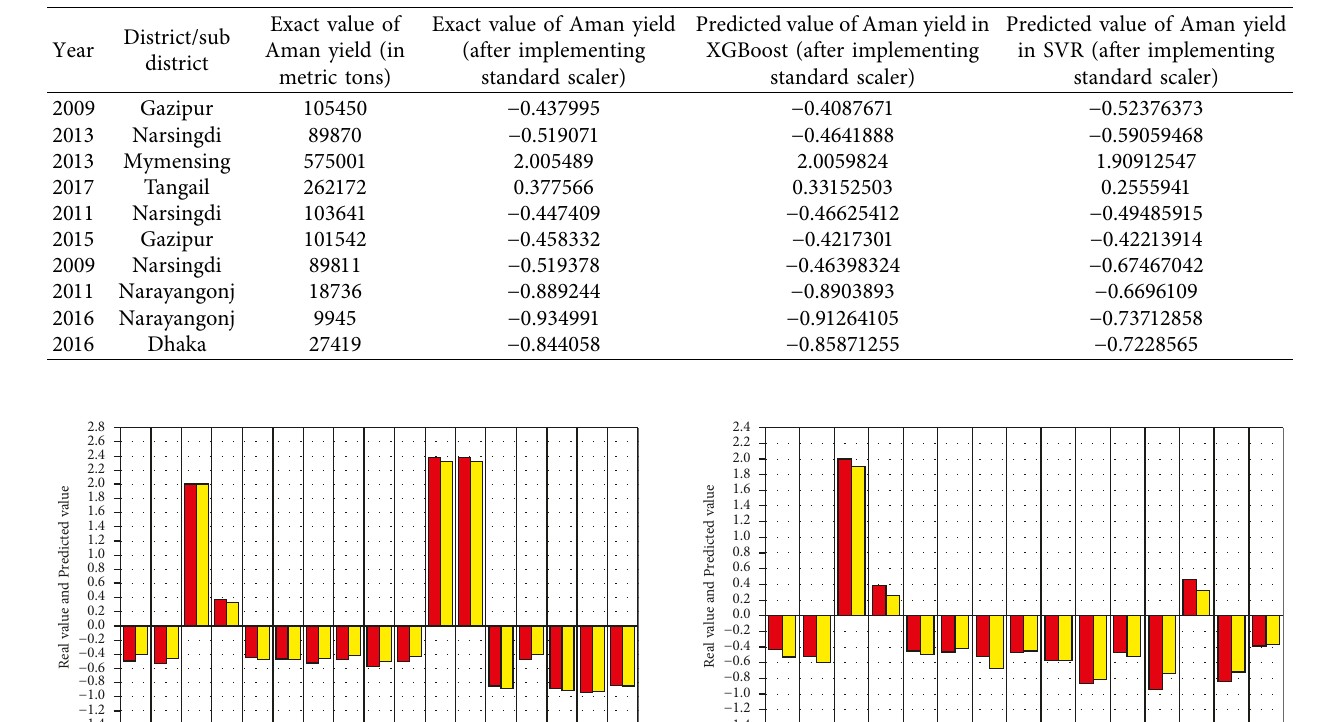
Table 4: The exact value and the predicted value of Aman yield in the different districts in different years.